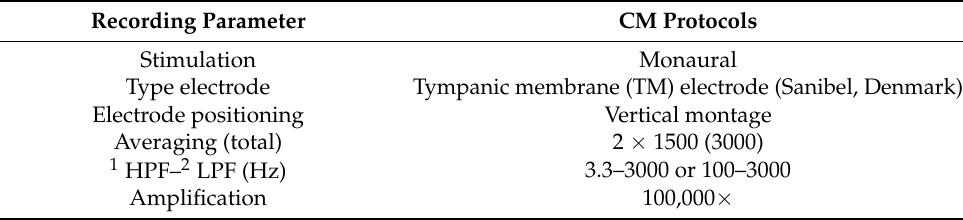
Table 2. Recording parameters for all CM protocols.